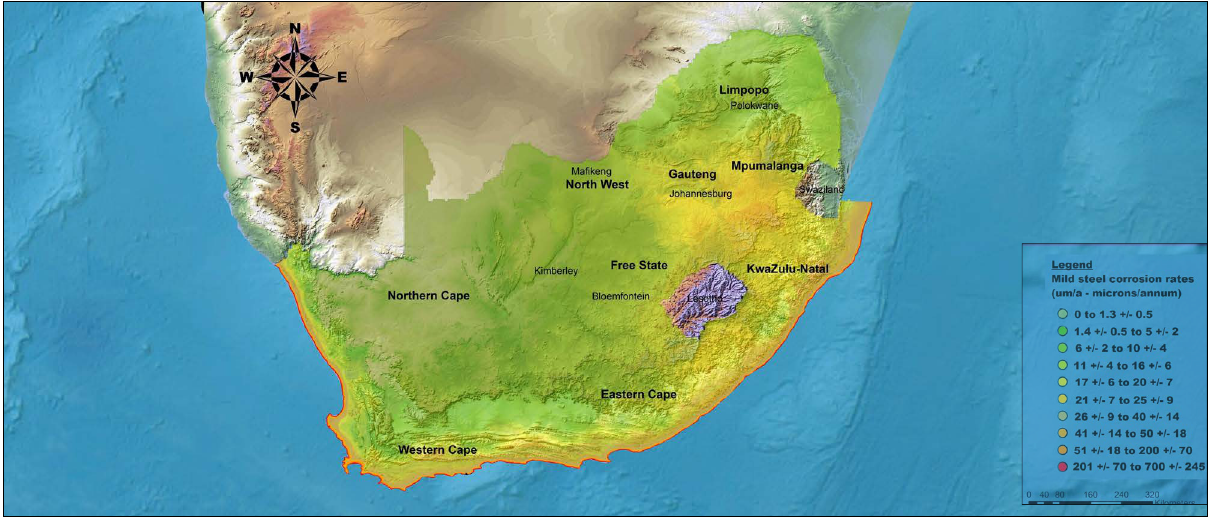
Meteorological data and first-year corrosion rates of mild steel for select historical and new corrosion monitoring sites